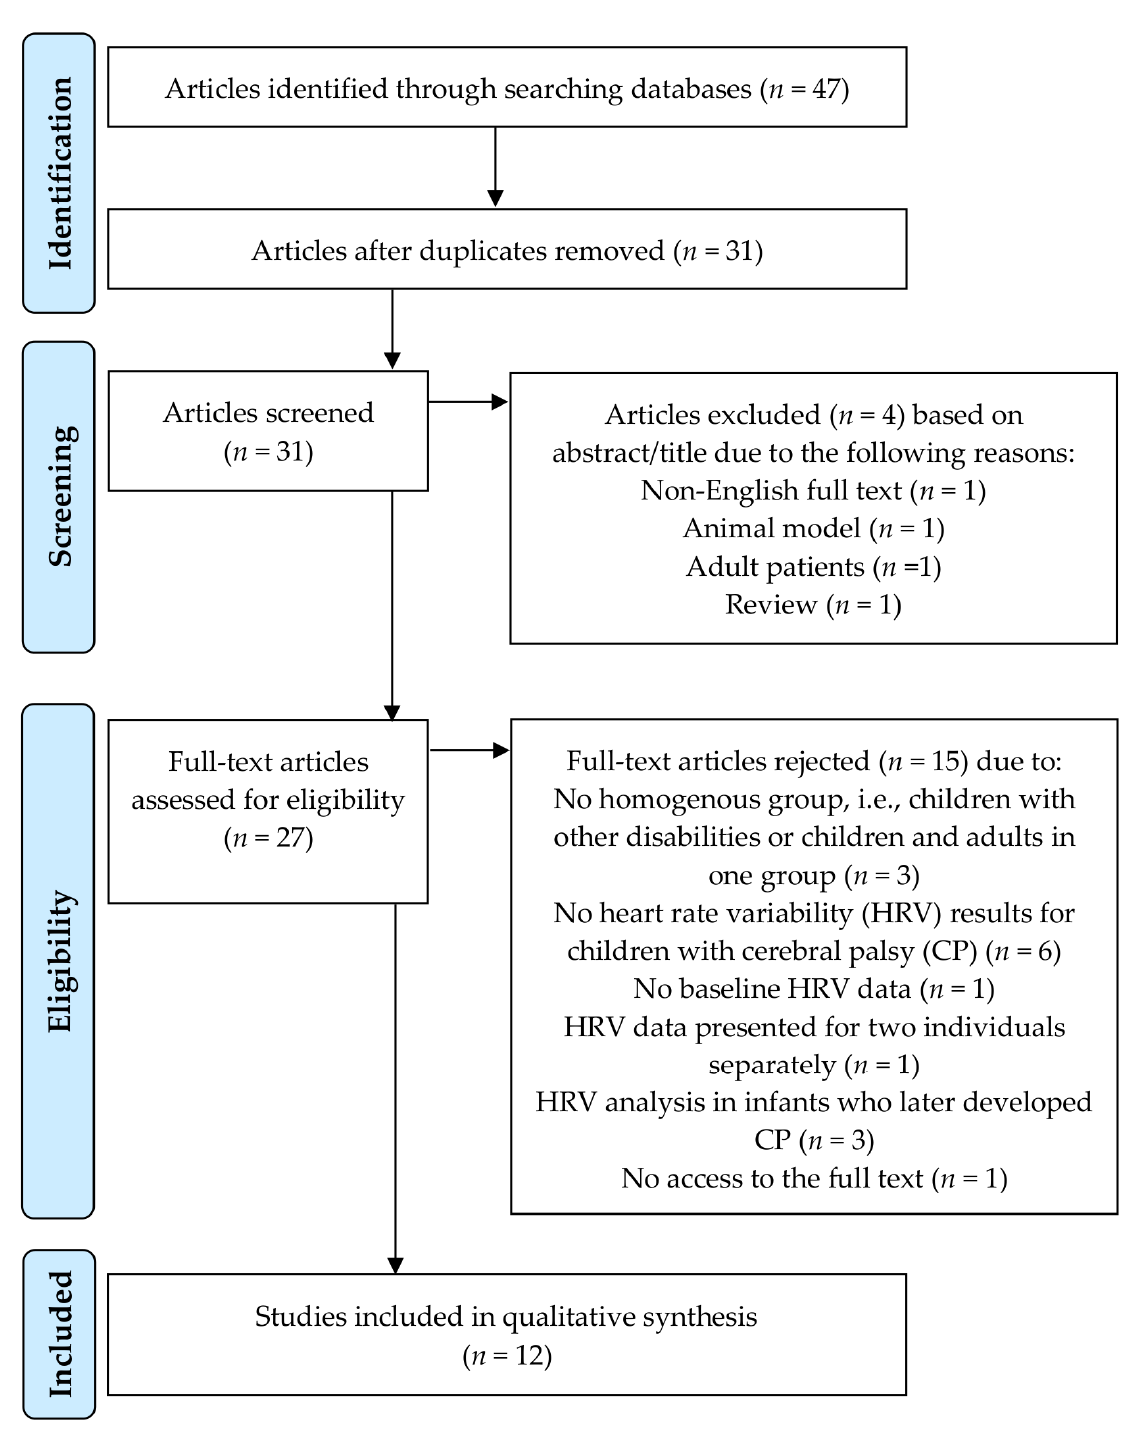
Figure 1. Preferred Reporting Items for Systematic Reviews and Meta-Analyses (PRISMA) flow diagram for the search process.